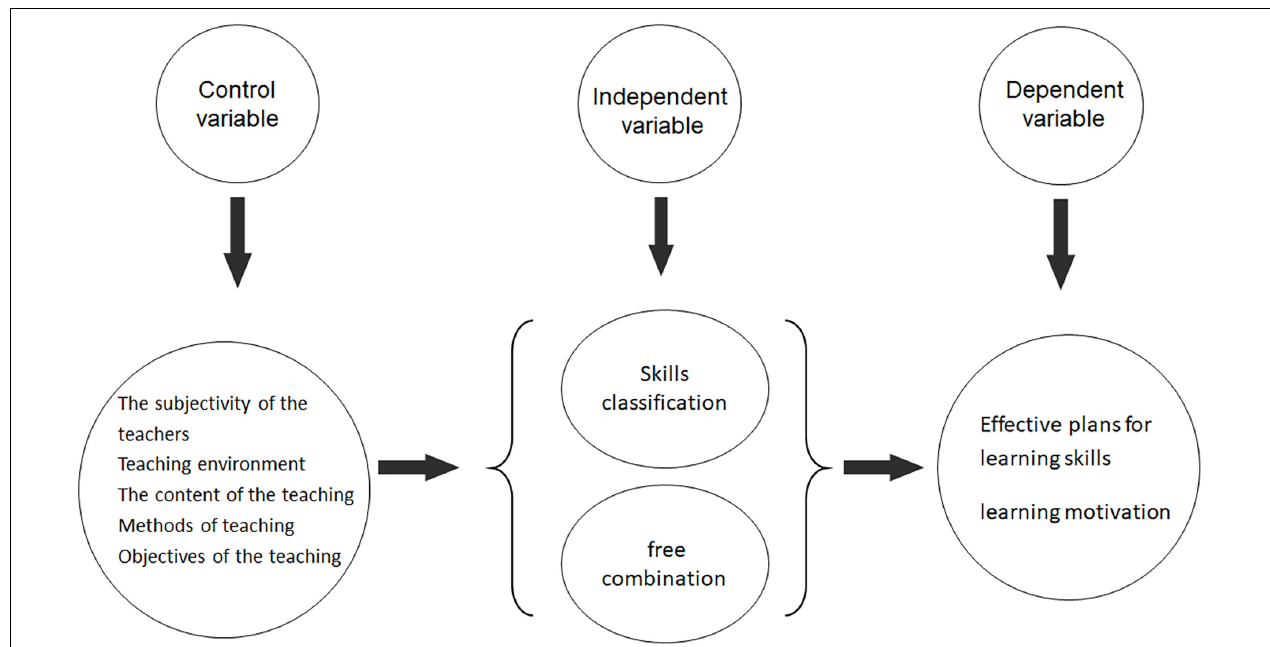
FIGURE 1 | Research architecture diagram.